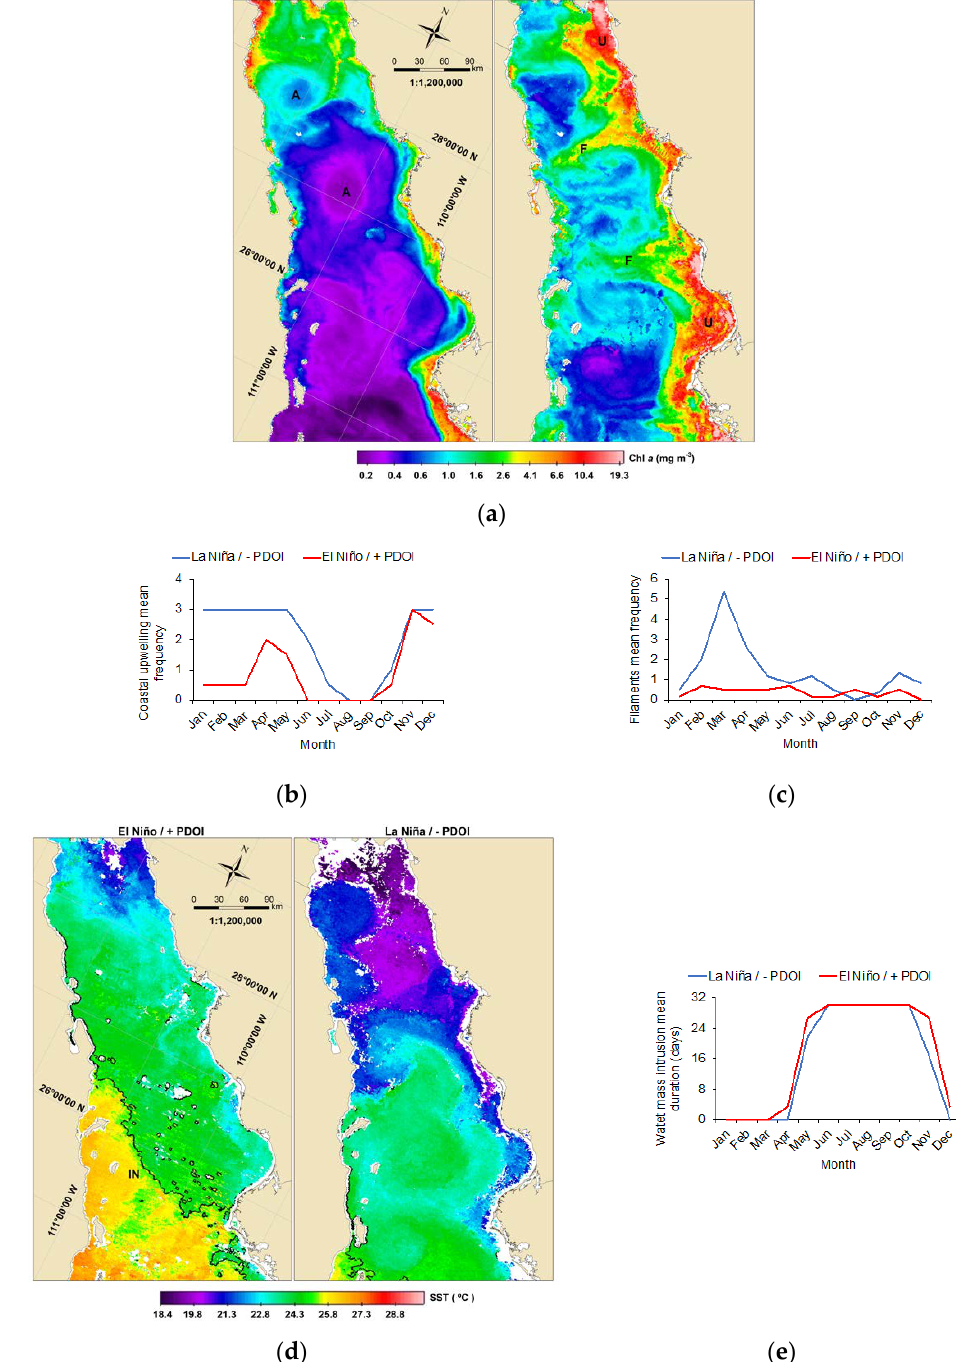
Figure 9. ( a ) Chlorophyll a satellite images exhibiting El Niño/+PDOI and La Niña/ − PDOI conditions in the Central Gulf of California; ( b ) Mean annual frequency of anticyclonic eddies during positive and negative ENSO/PDO. ( c ) Mean annual frequency of coastal upwelling during positive and negative ENSO/PDO; ( d ) Sea surface temperature satellite images exhibiting El Niño/+PDOI and La Niña/ − PDOI conditions in the Central Gulf of California; ( e ) Mean annual duration of the water mass intrusion during positive and negative ENSO/PDO. Figure 10a,d show Chl a and SST satellite images, respectively, of the SGC under positive/negative ENSO and PDO conditions. Coastal upwelling activity is reduced by ~64% during El Niño and positive PDO with respect to La Niña and negative